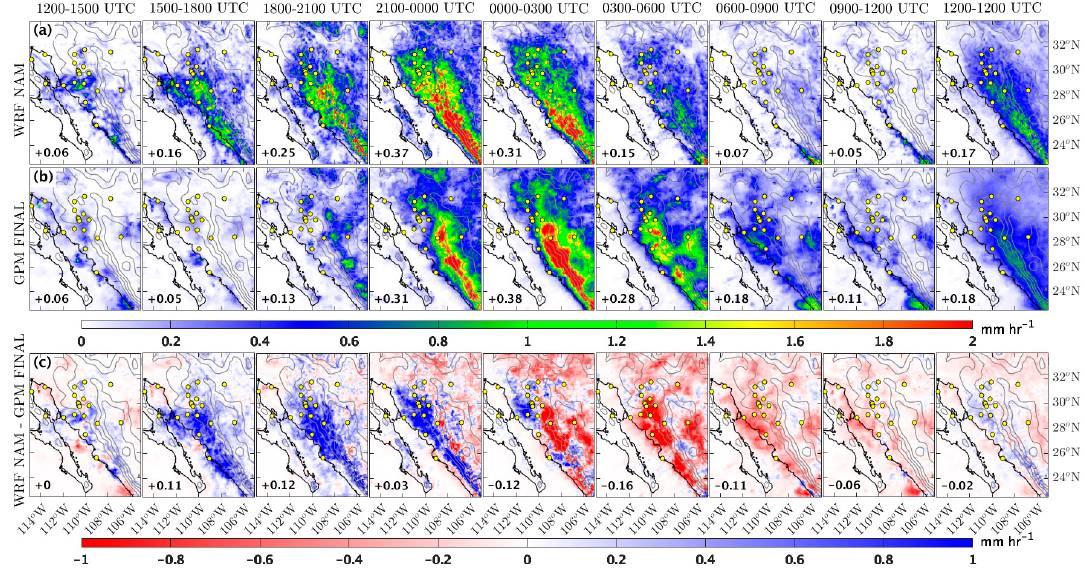
Figure 6. As in Figure 5, but for WRF-NAM simulations. Note that the WRF-NAM simulations exhibit wet bias in the early forecast hour compared to the WRF-GFS simulations. Mean hourly precipitation rate ( a ), GPM Final precipitation products ( b ), and model bias ( c